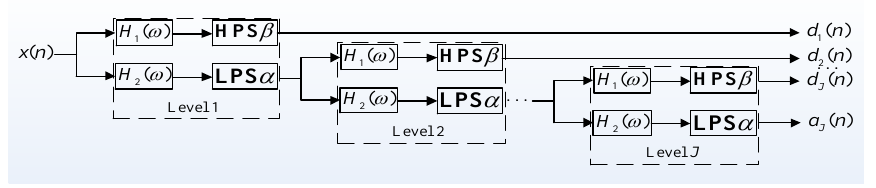
Figure 5. The analysis filter banks of tunable Q -factor wavelet transformation (TQWT).